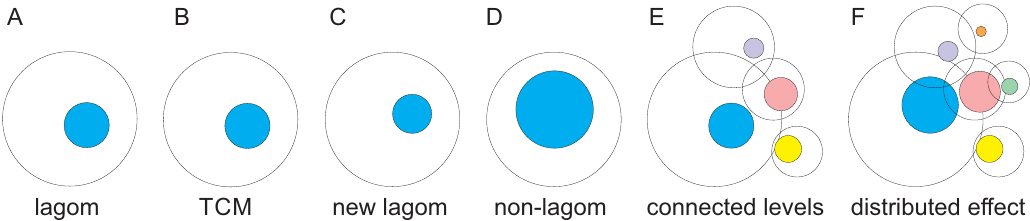
Figure2.Descriptionoflagomandnon-lagom. A.Thebluesphere indicateslagomandthewhitespherethespace of possible states. B. The effects of small or medium perturbation are restricted by TCMs thereby keeping the lagom extent of variation. C. Somewhat larger perturbation changes the extent and/or position of lagom. D. Larger perturbation causes the system to enter non-lagom state that is no more controlled by TCMs. E. Levels of molecules, systems etc. are highly connected. For each level the lagom extent is indicated as well as the possible range of heterogeneity. The colored spheres indicate lagom extents. F. Non-lagom extent in one level (blue) can affect some other levels and cause them to become non-lagom and extend to further levels. The effect on some levels is within the lagom extent and there is no change in the position or extent of lagom whereas others can enter non-lagom